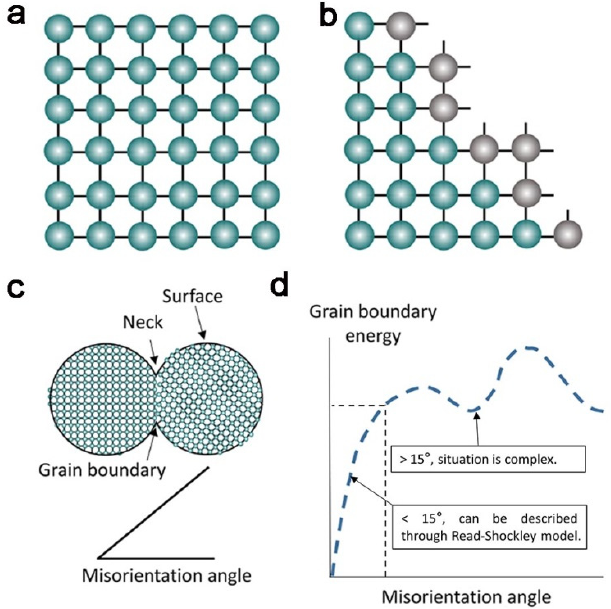
Figure 1. ( a ) Scheme of a single crystal structure, in which the atoms are in a repeating position, and the atomic bonds are linked between atoms. ( b ) Scheme of a free surface of a single crystal, showing disrupted atomic bonds. These dangling atomic bonds induce the surface energy; ( c ) scheme of two misoriented nanoparticles and the illustration of the misorientation angle; and ( d ) grain boundary energy changes with misorientation angle [25].